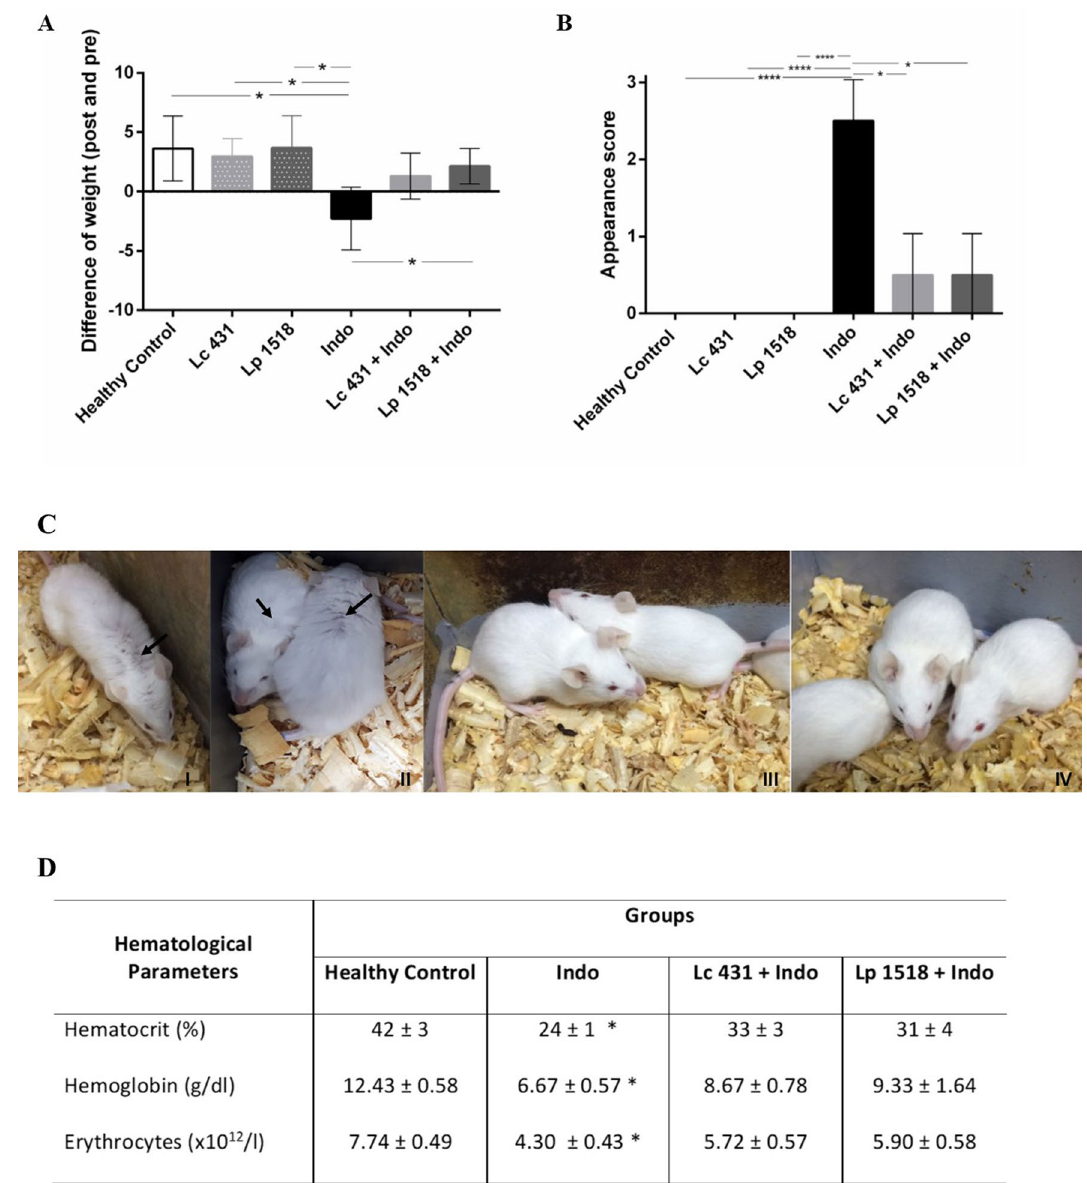
Figure 1. Clinical features of intestinal inflammation in animals. Balb/c mice supplemented with Lactobacillus casei CRL 431 (Lc 431), Lactobacillus paracasei CNCM I-1518 (Lp 1518), or water, for 7 and 5 days, received indomethacin injections on the last two days. Additional controls fed with Lc 431, Lp 1518 or water, received 2 PBS injections. ( A ) Body weight differences after and before the indomethacin injection. ( B ) Appearance score was evaluated according to Shrum et al. 51 . The line at the top of the bars indicates the comparison between the two groups, * p < 0.05. ( C ) Photography of mice. Panels I- and II- show important patches of piloerected hair pointed by black arrows, in the Indo group. By contrast, the coat is smooth in Lc 431 + Indo and Lp 1518 + Indo groups (Panel III- and IV-, respectively). ( D ) Evaluation of red blood cells on the day mice were euthanized. Stars show the comparison to the healthy control group. * p <